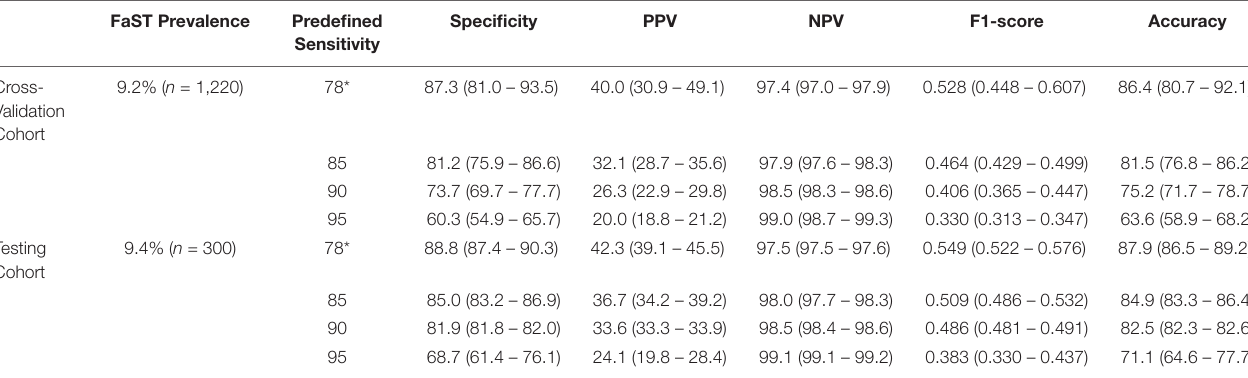
TABLE 2 | Performance of DL